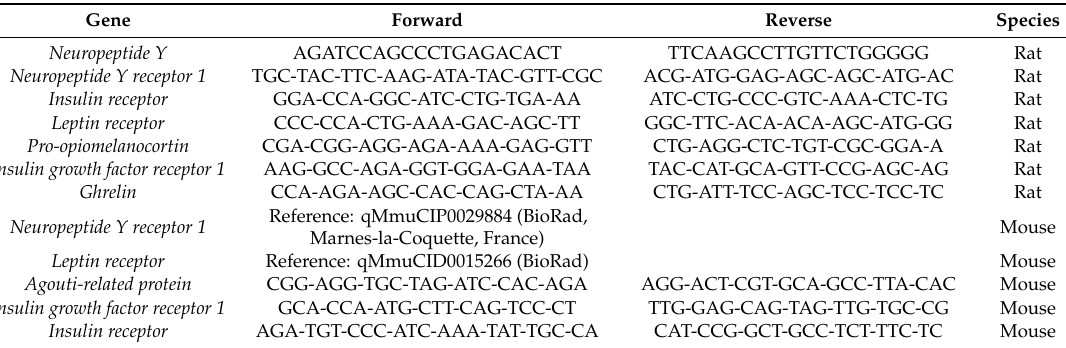
Table 2. Sequences of primers used for quantitative